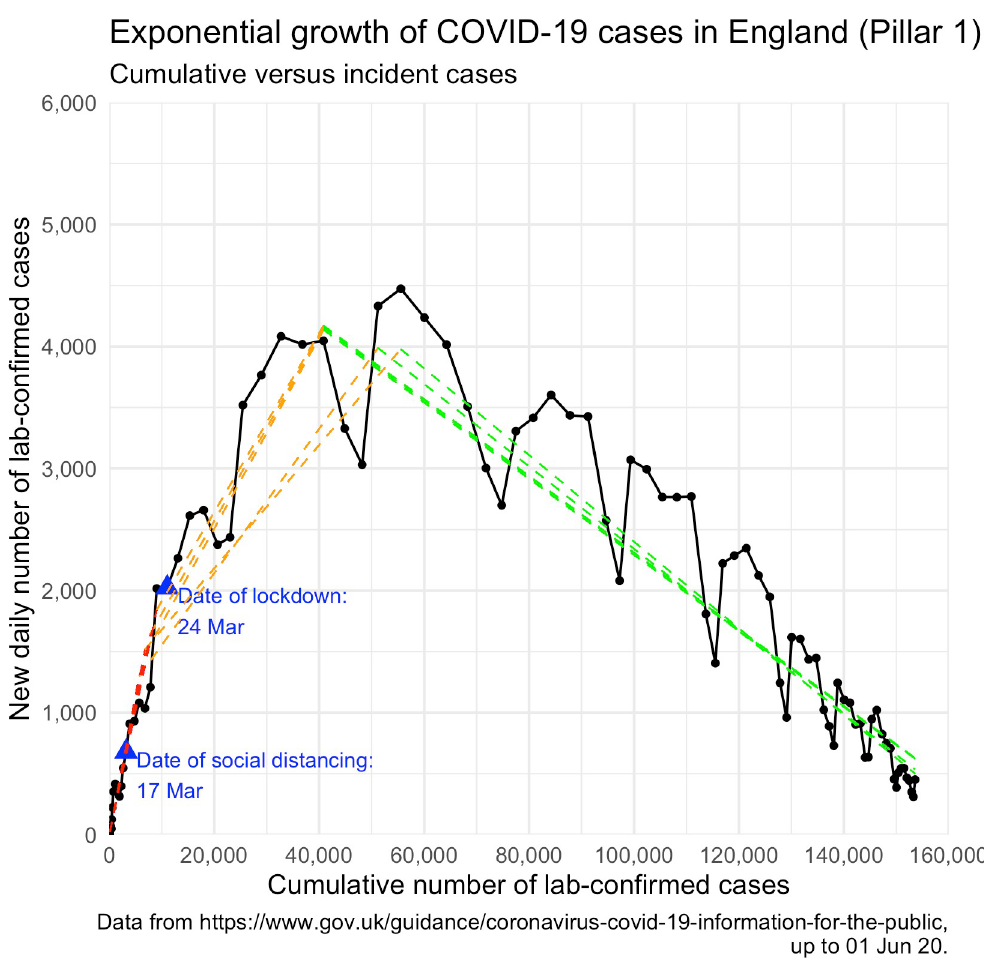
Fig 1. Observed relationship between cumulative and daily number of COVID-19 cases in England. The observed relationship between cumulative and daily number of new Pillar 1 lab-confirmed cases in England from 30 January to 1 June, with the five best-fitting spline models overlaid (see Table 1). Three distinct growth periods are identified, which may reasonably be attributed to measures implemented by the UK government. Growth period 1 (in red) indicates initial uncontrolled growth; growth period 2 (in orange) indicates growth under social distancing; growth period 3 (in green) indicates growth under lockdown. Dates in blue indicate first full days under social distancing and lockdown measures,